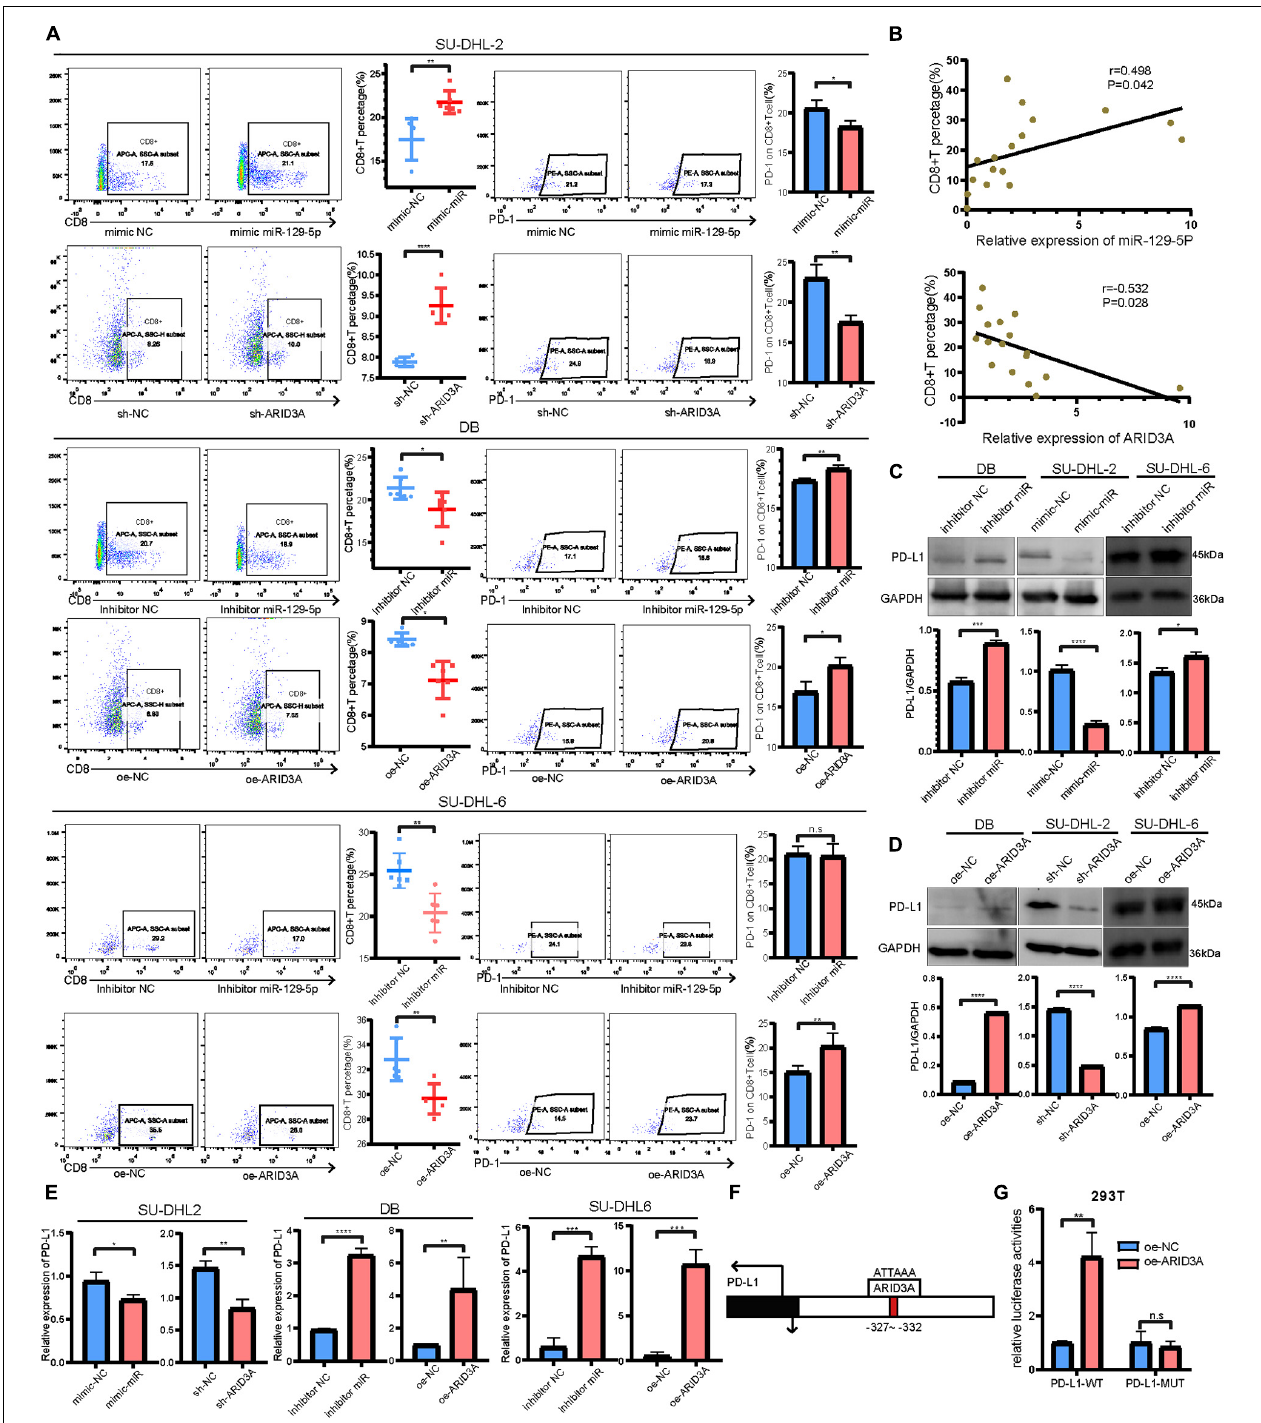
FIGURE 5 | (A) CD8 + T cell percentage and the surface PD-1 expression were determined using flow cytometry analysis when co-cultured with SU-DHL-2, DB and SU-DHL-6 cells and transfected cells. Mean ± SD ( n = 6). (B) Pearson’s correlation curve showing the positive relation between CD8 + T cells and miR-129-5p and the negative relation between CD8 + T cells and ARID3A in DLBCL peripheral blood. (C,D) Western blotting and densitometric analyses showing PD-L1 protein levels in transfected and negative control DB, SU-DHL-2 and SU-DHL-6 cells. (E) Expression of PD-L1 mRNA in transfected and negative control cells were determined using RT-qPCR. (F) Predicted ARID3A binding site in the PD-L1 promoter were acquired using JASPAR. (G) Dual-luciferase reporter gene assays were performed to show that ARID3A regulated PD-L1 as a transcription factor. Mean ± SD ( n = 3). * P < 0.05; ** P < 0.01; *** P < 0.001; **** P < 0.0001.